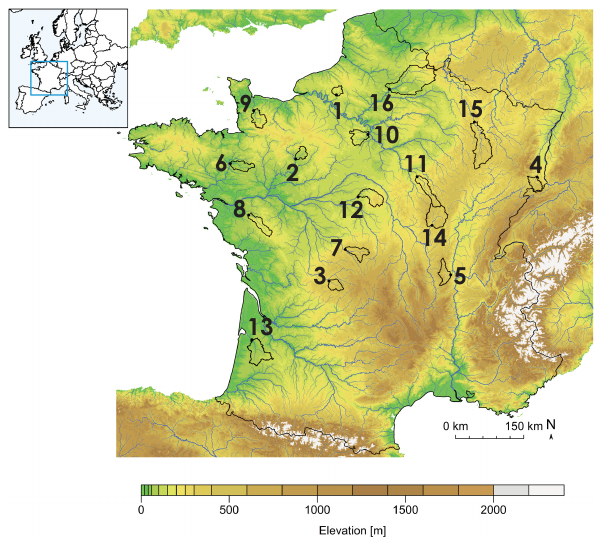
Figure 1. Location of the studied catchments in France, identified by their numbers (see Table